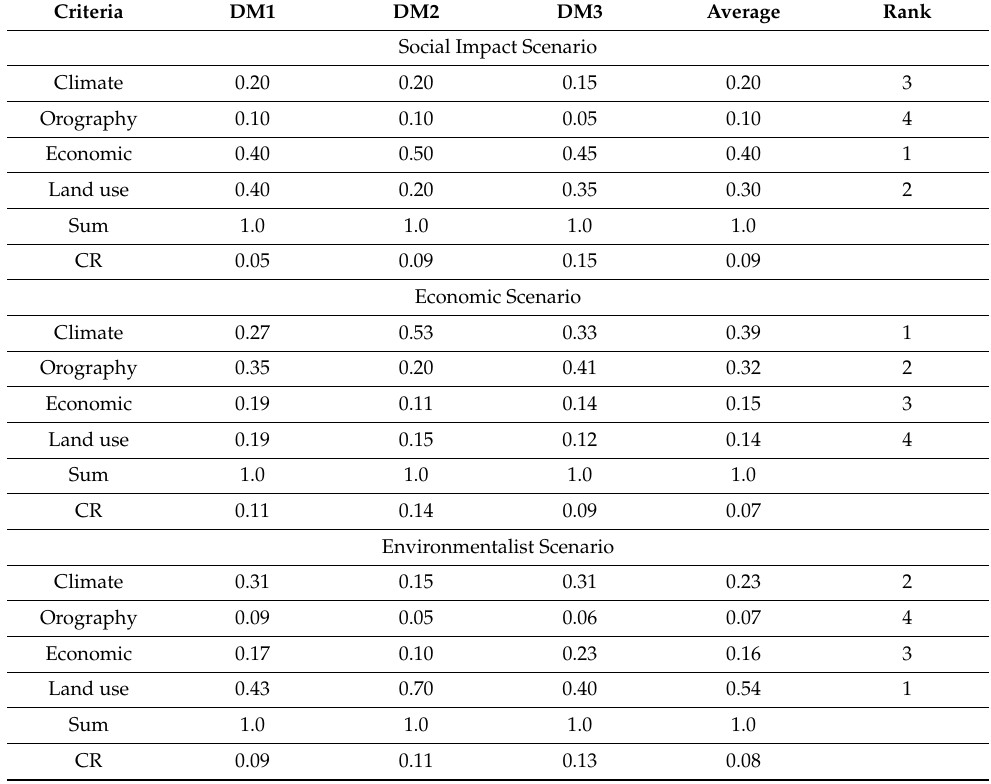
Figure 3. Existing solar farm used for the validation. Table 6. The weights of the criteria for each scenario. The CR is consistently under 0.2. DM =